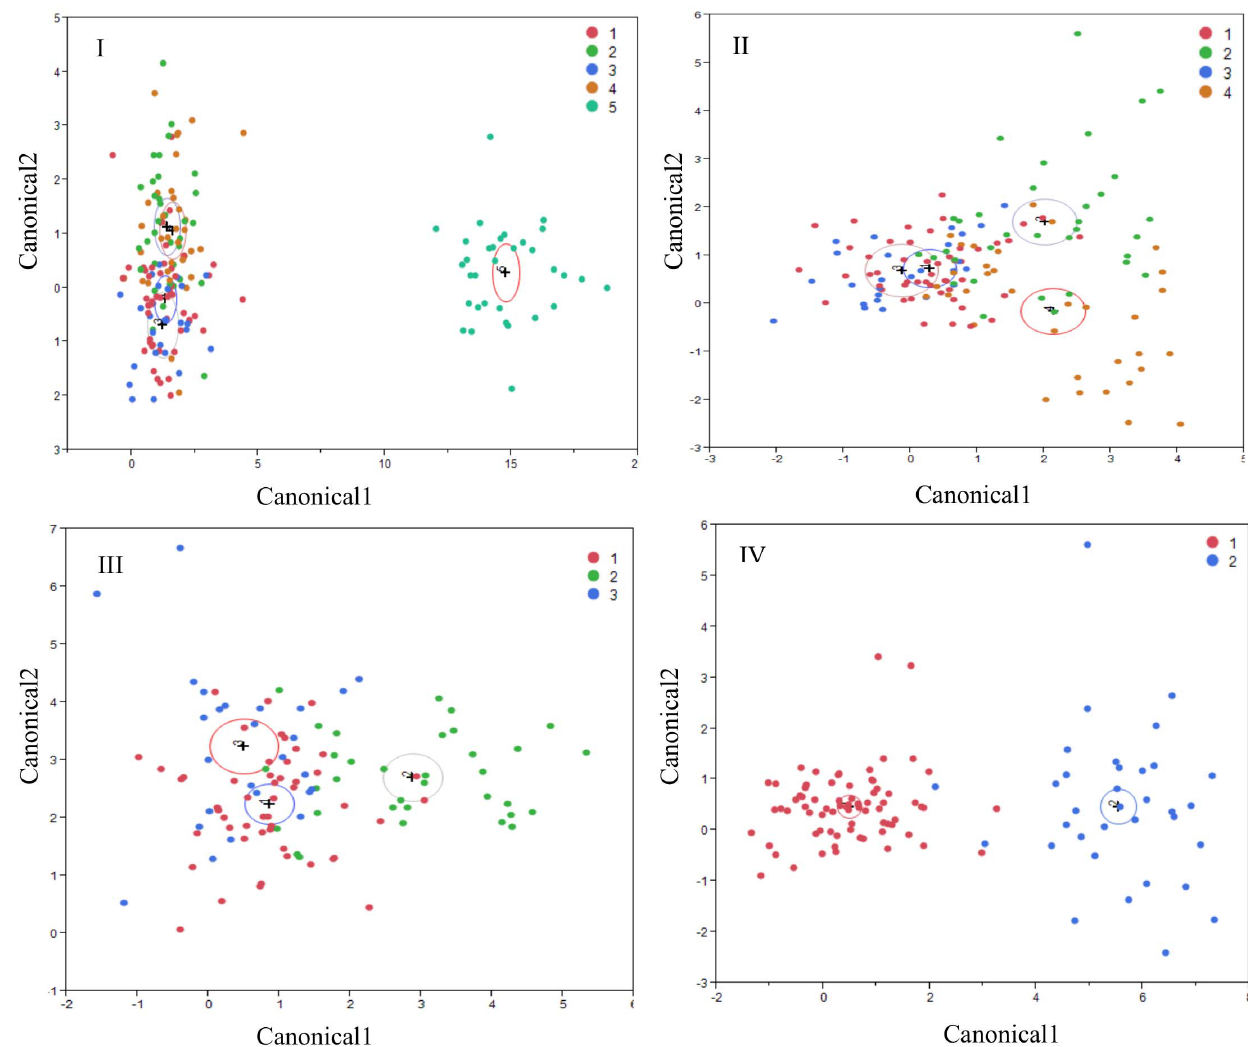
Figure 2. Discriminant analyses of milk samples microbiome. I. Discriminant analysis that was performed using all 5 groups of milk samples (1=healthy quarter, somatic cell count , 20,000; 2=healthy quarter, somatic cell count ranged from 21,000 to 50,000; 3=healthy quarter, somatic cell count . 50,000; 4=subclinical culture positive quarters, somatic cell count . 400,000; 5=clinical mastitis culture negative quarters). II. Discriminant analysis that was performed after excluding samples derived from clinical mastitis, culture negative quarters (group 1–4 included). III. Discriminant analysis performed using groups 1–3. IV. Discriminant analysis of milk microbiome from healthy quarters (groups 1–3) by farm (farm A and B). All discriminant analyses were performed in JMP Pro (SAS Institute Inc. North Carolina) using the bacterial genus prevalence in each sample as covariates and the sample group (I, II, III) or farm (IV) as the categorical variable. Only genera significant for the discrimination were included in the final models. Groups are colour coded in each figure. The center of gravity for each group is represented by a + sign and variability by a